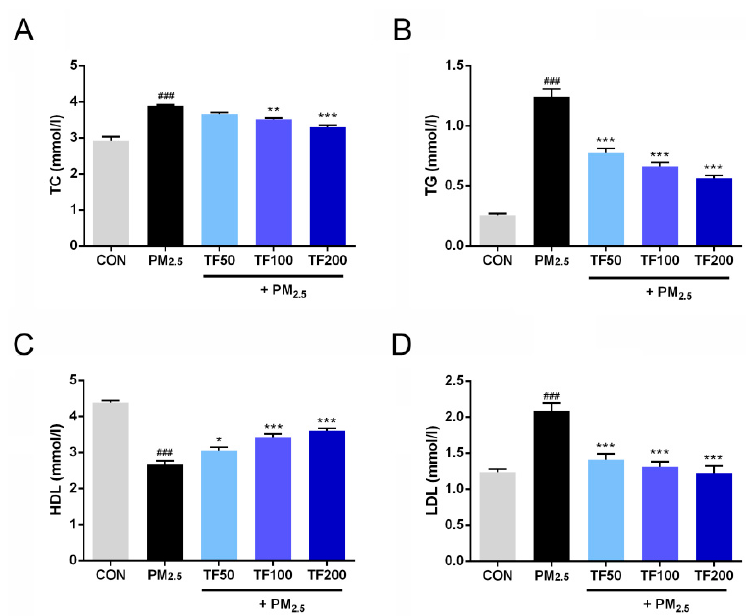
Figure 3. Effects of TF in PM 2.5 exposure induced NAFLD on plasma total cholesterol (TC) ( A ), triglycerides (TG) ( B ), high-density lipoprotein cholesterol (HDL) ( C ), and low-density lipoprotein cholesterol (LDL) ( D ) in the following groups: Control group (CON), PM 2.5 exposure group, PM 2.5 + TF 50 mg/kg group, PM 2.5 + TF 100 mg/kg group and PM 2.5 + TF 200 mg/kg group. All the results were presented as mean ± SE ( n = 10). ### p < 0.001 vs. the CON group; * p < 0.05, ** p < 0.01, *** p < 0.001 vs. the PM 2.5 group.